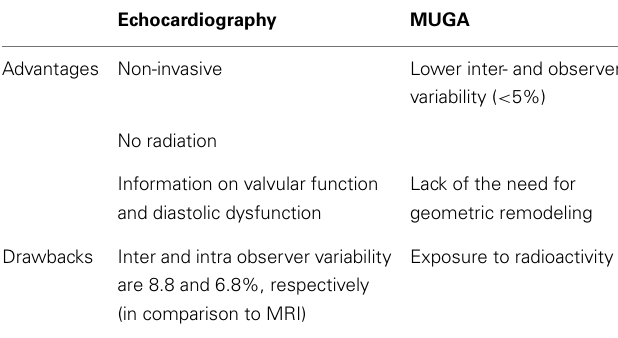
Table 2 | Imaging modalities in the detection of